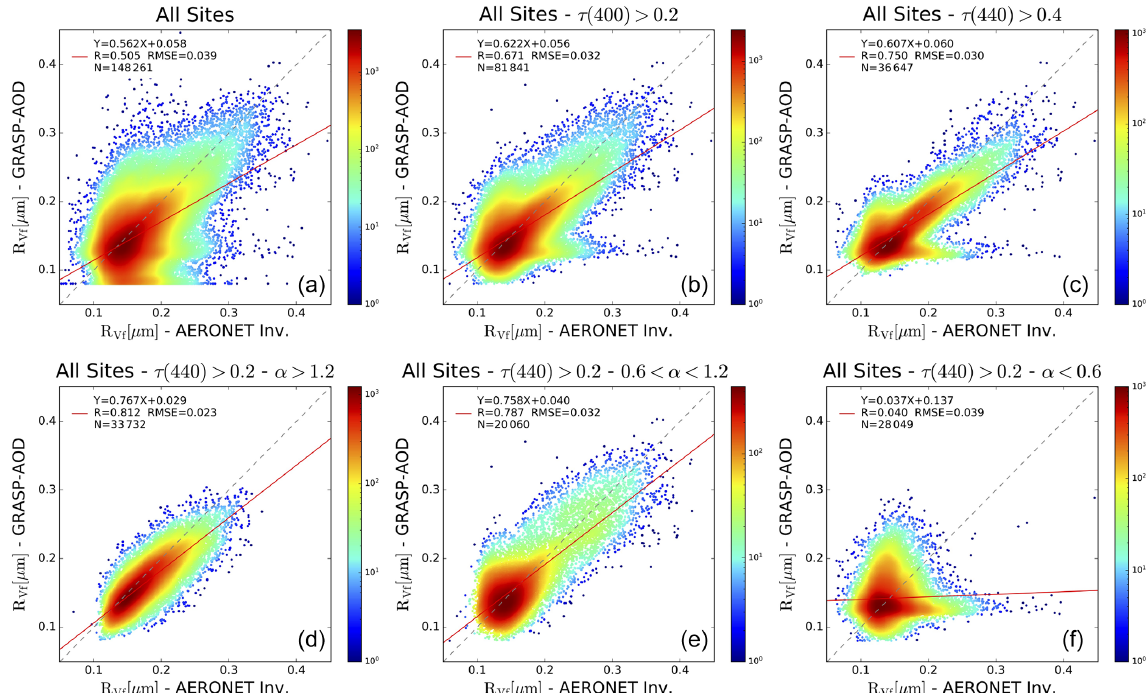
Figure 6. Comparisons between the fine-mode volume median radius ( R Vf [µm]) obtained by the GRASP-AOD and AERONET aerosol retrieval algorithm for all sites considered in the analysis (Table 1) for the period 1997–2016 using different thresholds for τ( 440 ) and Ångström exponent values. (a) – (c) analyze the effect of different lower limits of τ( 440 ) (from left to right): all retrievals ( τ( 440 ) > 0 . 02), retrievals with τ( 440 ) > 0 . 2 and retrievals with τ( 440 ) > 0 . 4. (d) – (f) analyze the results for the retrievals with τ( 440 ) > 0 . 2 and for different ranges of the Ångström exponent (from left to right): retrievals with α > 1 . 2, retrievals with α between 0.6 and 1.2, and finally, retrievals with α < 0 . 6. Color bars represent data density in a 0 . 01 × 0 . 01µm grid. A logarithmic scale has been chosen given the strong data density between